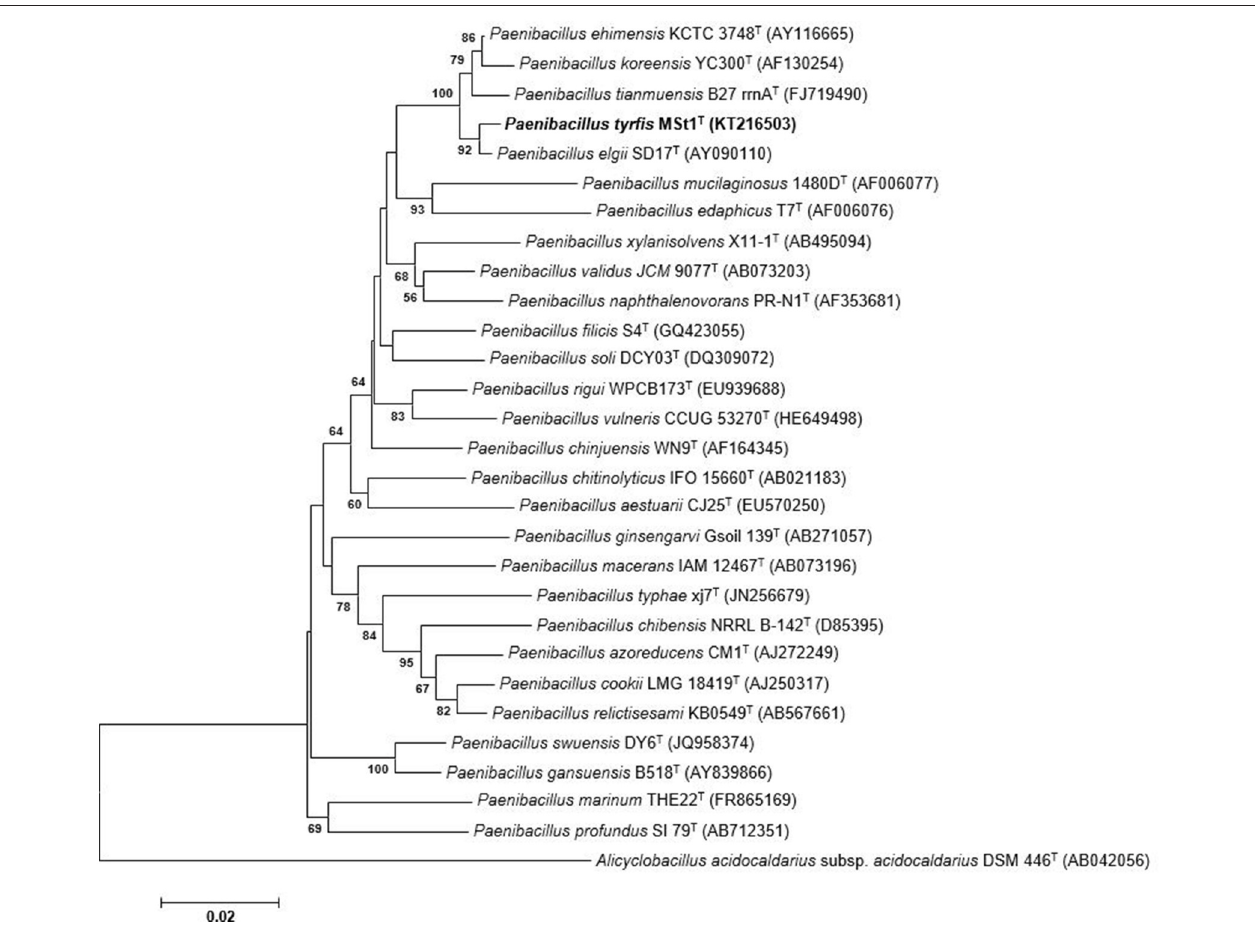
FIGURE 1 | Neighbor-joining tree based on 16S rRNA sequences showing relationships between strain MSt1 T and representatives of other related taxa. Bootstrap values ( > 50%) based on 1000 resampled datasets are shown at branch nodes. Alicyclobacillus acidocaldarius subsp. acidocaldarius DSM 446 T was used as the outgroup. Bar, 2 substitutions per 100 nucleotide